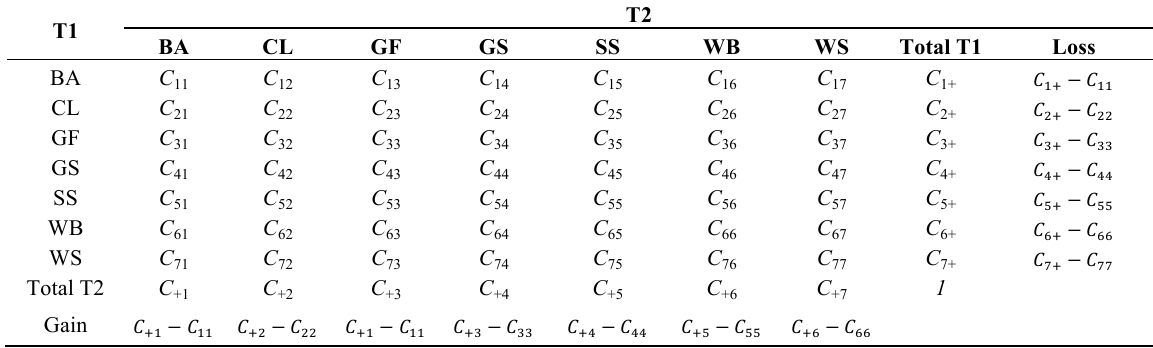
land cover matrix ( C is any conversion from one cover class to another). 77